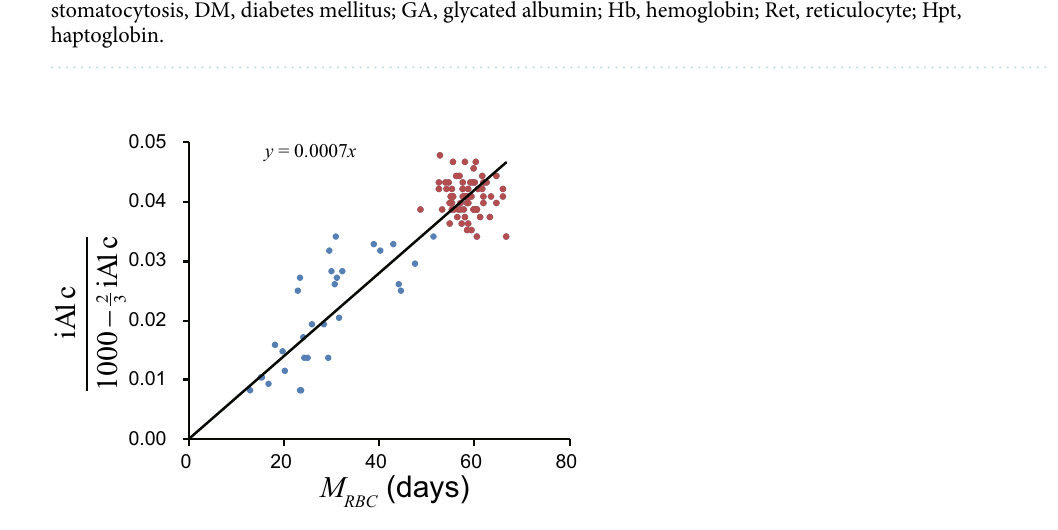
Figure 2. Relationship between EC derived M RBC and iA1c/(1000−(2/3)iA1c). Red circles denote non- hemolytic participants and blue circles denote hemolytic patients. Black line denotes regression line through origin.